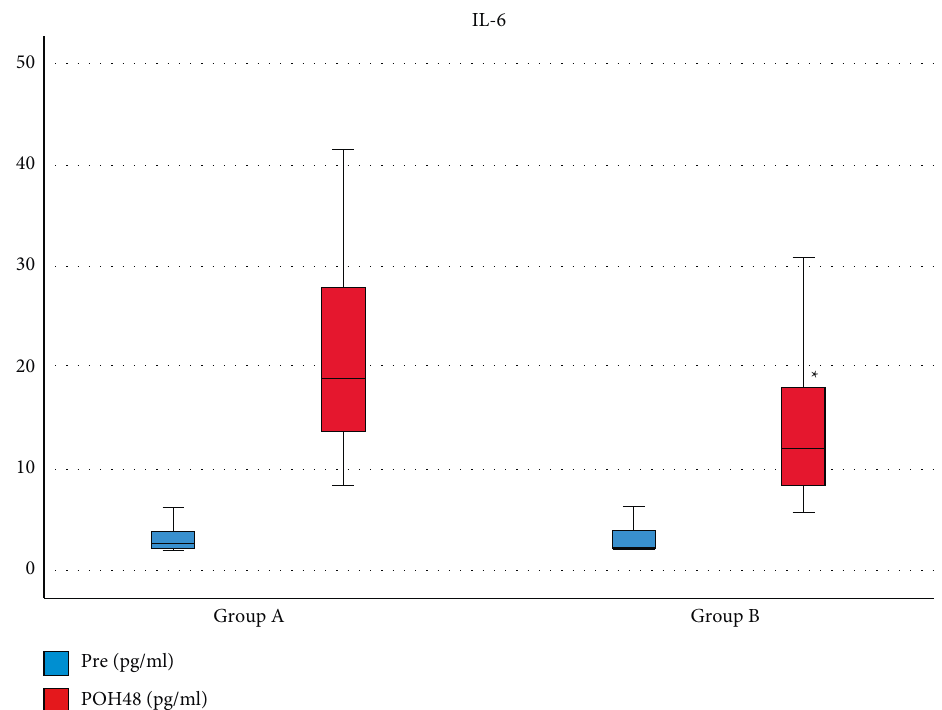
Figure 5: Mean C-reactive protein (CRP) before operation (Pre) and postoperative 48 hours (POH48), # P < 0 . 05.